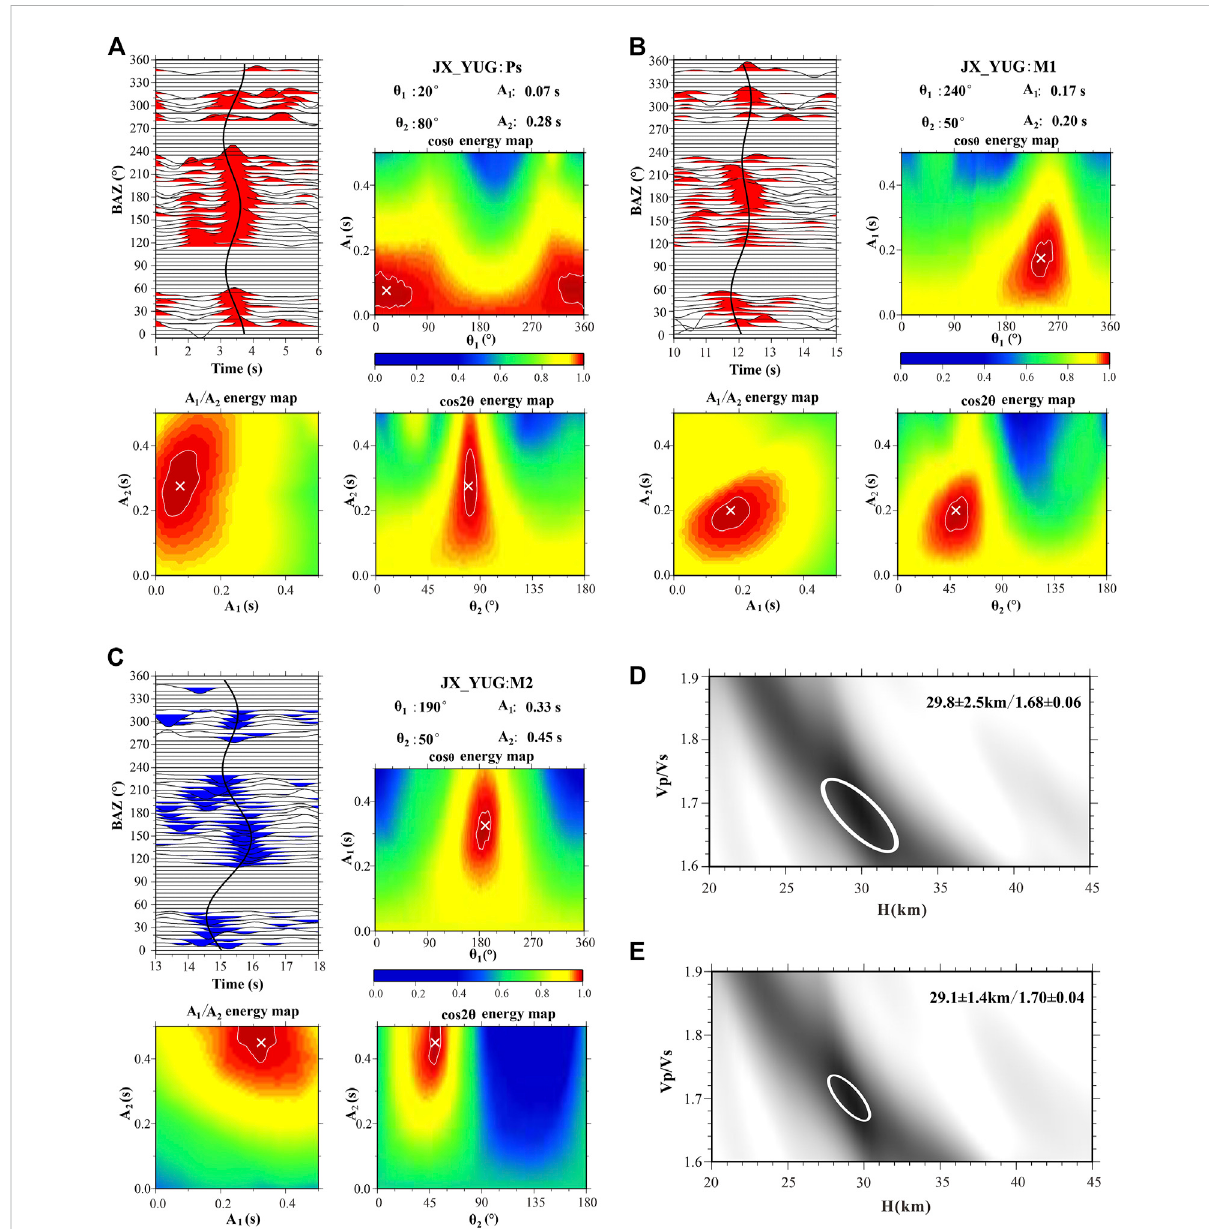
FIGURE 4 Harmonic fi tting of Ps (A) , M1 (B) , and M2 (C) for JX_YUG. The black lines represent the arrival times of Ps, M1, and M2 phases. The cross marks indicatethebestsolutions,andthe99%contoursshowtheempiricaluncertainty.H – κ domainenergymapsareshownwithweightingfactorsof0.7/ 0.2/0.1 (D) inH – κ stackingand0.6/0.3/0.1 (E) inH – κ – cstacking.H, κ ,andtheiruncertainties( σ H, σκ )arelistedinthetopright.Theerrorellipseswith one standard deviation (Zhu and Kanamori, 2000) are marked with white